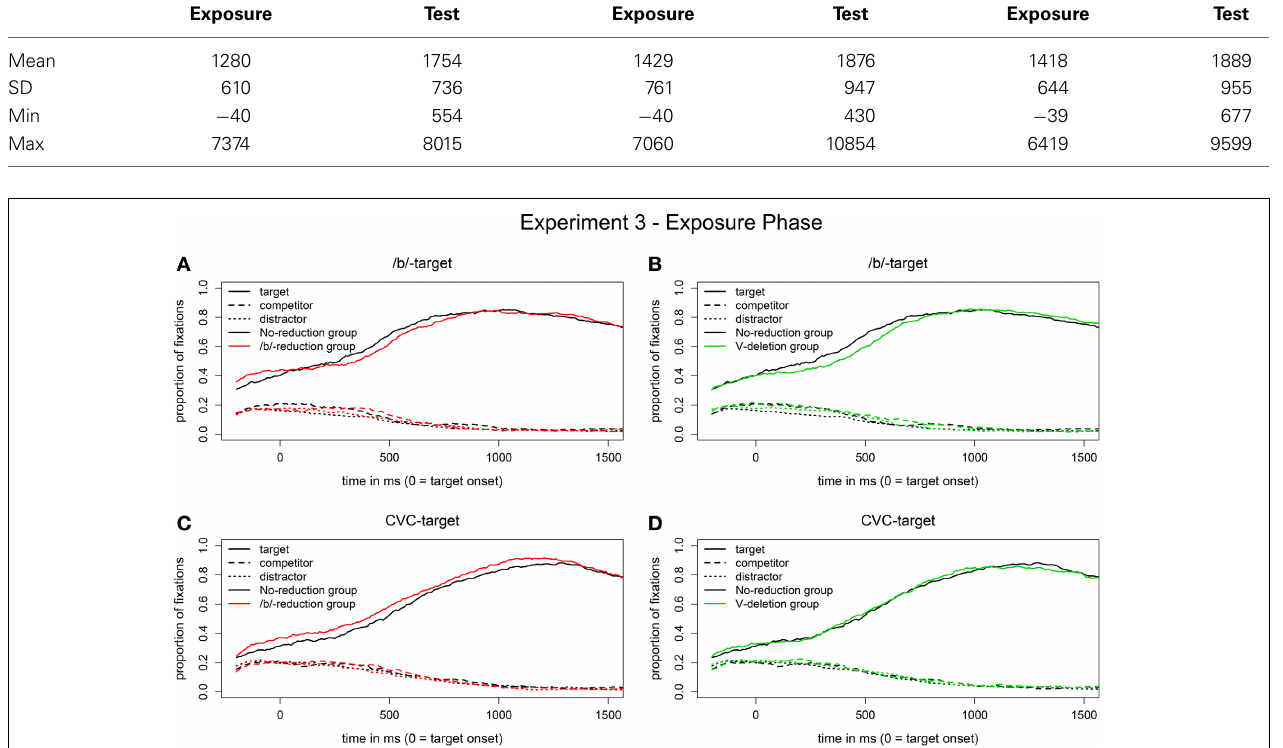
FIGURE 6 | Proportion of fixations in the segmental reduction condition [visual /b/-targets; (A,B)] and in the syllabic reduction condition [visual CVC-targets; (C,D)] in the exposure phase of Experiment 3. The /b/-words